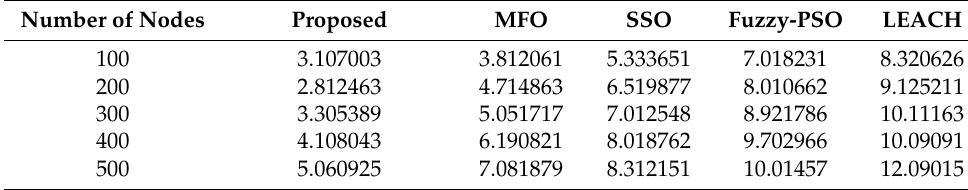
Table 7. Comparison of packet delivery ratio with various routing protocols. Number of Nodes